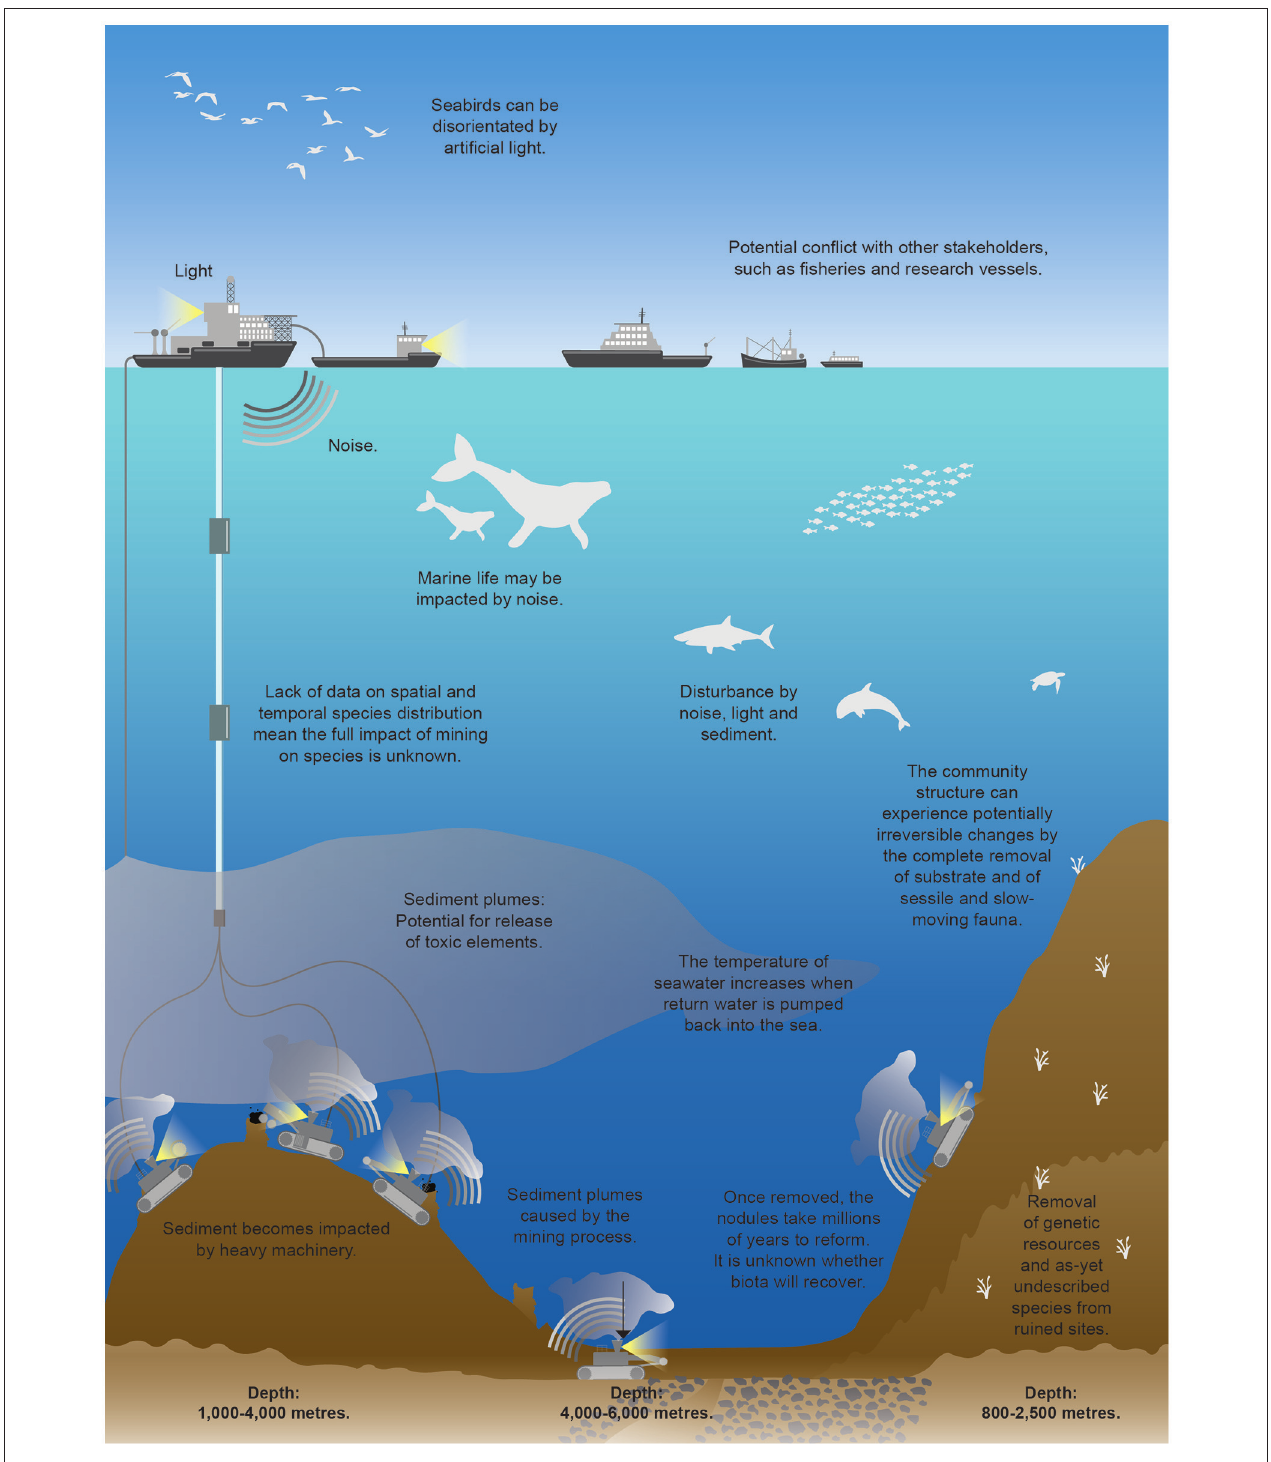
FIGURE 5 | A schematic showing the potential impacts of deep-sea mining on marine ecosystems. Schematic not to scale.